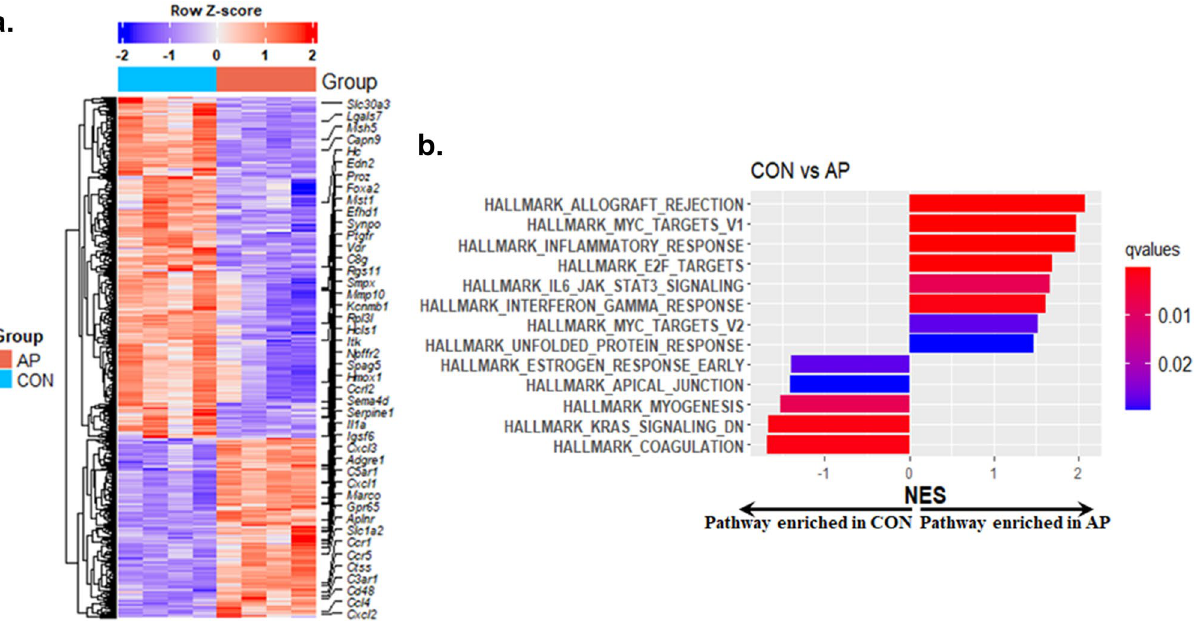
Figure 4. ( a ) Differentially expressed genes (DEGs) obtained from placental samples of control (CON) and air pollution (AP) exposed mice. DEGs were selected based on FDR < 0.05 and Log2Foldchange > 2. Genes which are part of any of the pathways in the right panel have been labeled. A full list of differentially expressed genes can be found in Supplementary Table 3. ( b ) List of Hallmark pathways positively or negatively enriched between AP and CON groups obtained using GSEA are